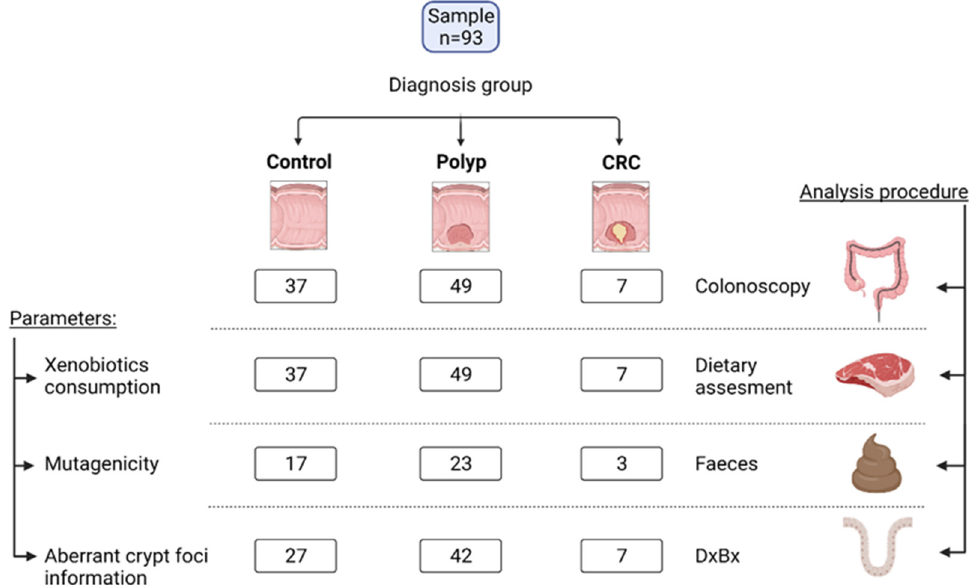
Figure 1. Graphical information on the study design and sample size. The left column information indicates the variables studied and the right column text indicates the methodology or the raw material used to study those variables. Each box in the central part of the figure shows the number of volunteers belonging to the different diagnosis group, with available data for each of the determinations. CRC, colorectal cancer; DxBx, pathological analysis.